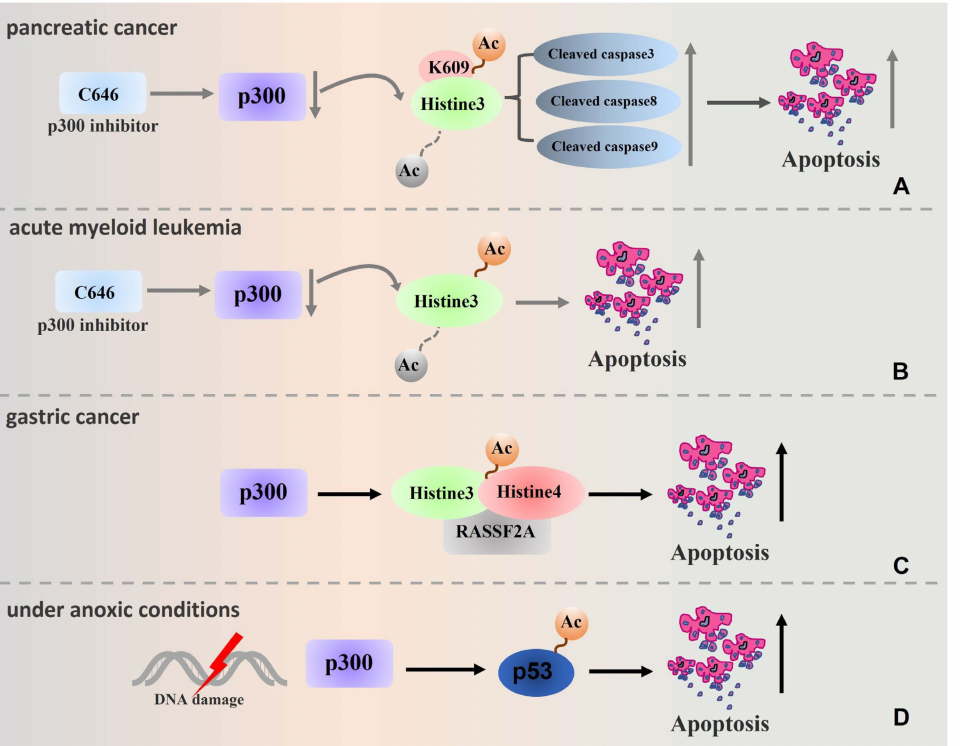
Figure 4. Schematic representation of pathways involved in the regulation of apoptosis by p300. ( A ) In pancreatic cancer studies, C646 treatment was followed by interference with p300 followed by inhibition of acetylation of H3K27, leading to increased expression of apoptosis-related proteins such as cleaved caspase 3, 8 and 9 and promoting cell apoptosis. ( B ) C646 treatment leads to apoptosis in AML1-ETO positive AML cell line and primary parental cells, which may be associated with p300-mediated histone acetylation. ( C ) p300 is involved in the acetylation of the Histones H3 and H4 on RASSF2A promoter and regulates the expression of RASSF2A, thus inducing apoptosis of gastric cancer cells. ( D ) p300 acetylates p53 and regulates apoptosis in the presence of hypoxia or DNA damage (Remarks: The grey arrow is the related process in which p300 inhibitors participate in regulation, and the dotted line is the process in which modification types are